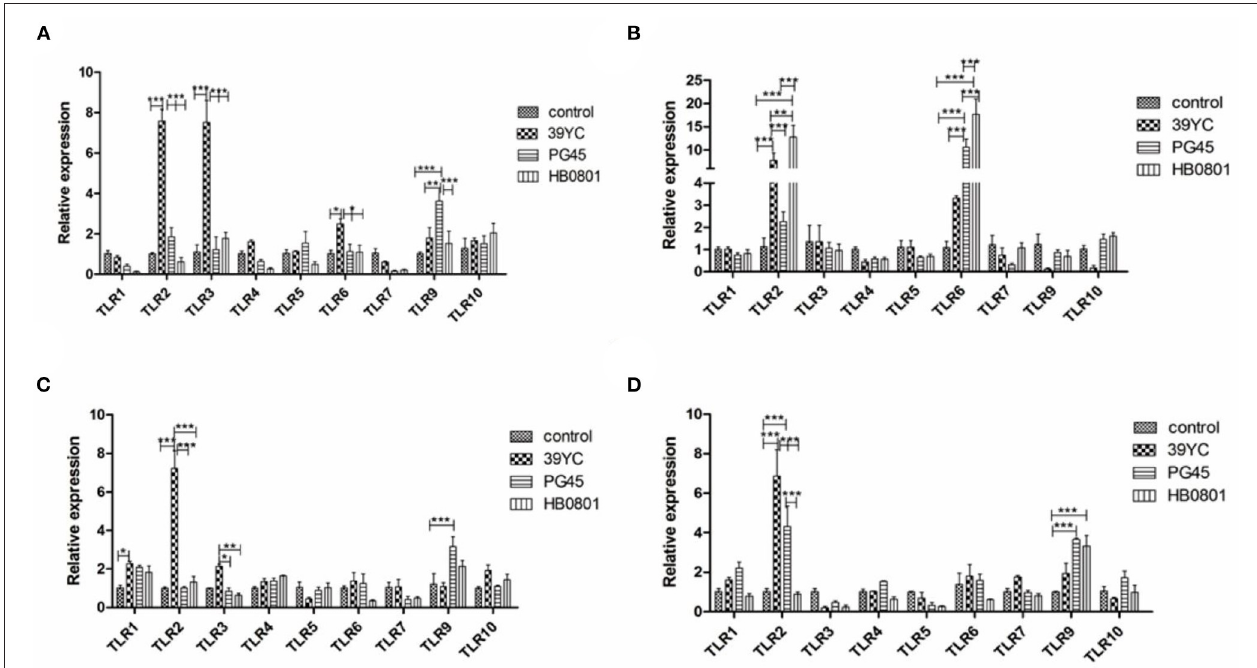
FIGURE 2 | M. bovis activated TLRs expression in BMECs. TLRs expression on BMECs induced by M. bovis at different time, (A) 10h post-infection (hpi), (B) 16 hpi, (C) 20 hpi, (D) 24 hpi. * p < 0.05, ** p < 0.01, and *** p < 0.001.